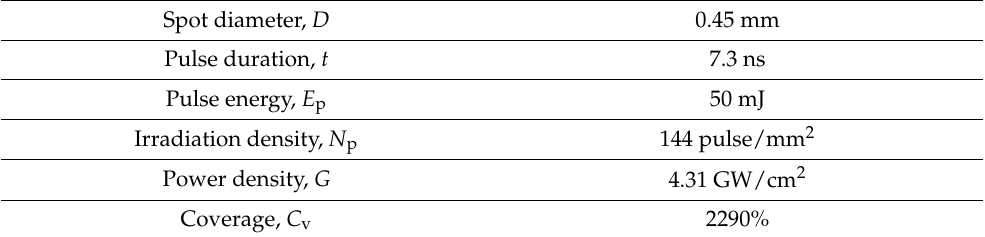
Figure 3. Schematic of the laser peening (LP) procedure: ( a ) LP device setup and ( b ) laser tracking during LP. Table 2. Laser peening